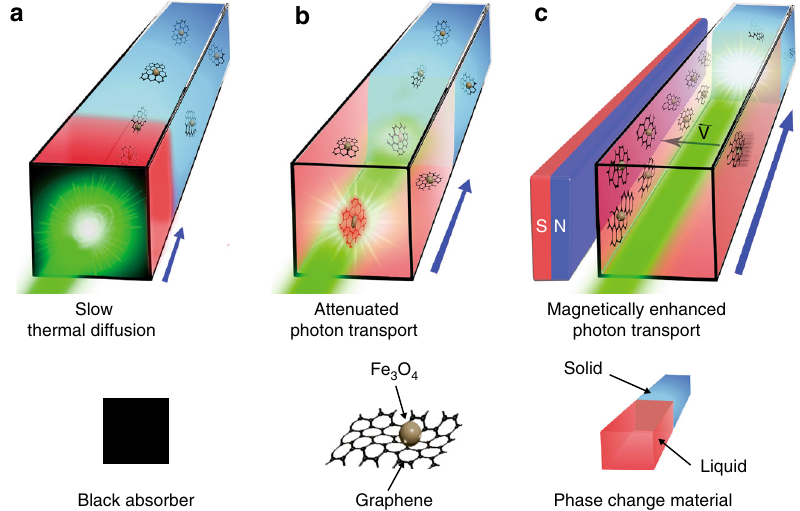
Fig. 1 Solar-thermal energy storage within phase-change material composites. a Thermal-diffusion-based thermal charging. The incident light was converted into thermal energy by a black absorber fi lm to charge thermal storage composites through thermal diffusion. Movement of charging interface was limited by slow thermal diffusion. b Photon-transport-based optical charging. The quick attenuation of incident light in the charged (liquid) state limits further light penetration. Movement of the charging interface was limited by attenuated photon transport. c Magnetically enhanced photon-transport- based optical charging. The dynamic removal of the optical absorbers from the optical charging path enables continuous photothermal conversion at the charging interface. Movement of charging interface was accelerated by the dynamic tuning of the distribution of the optical